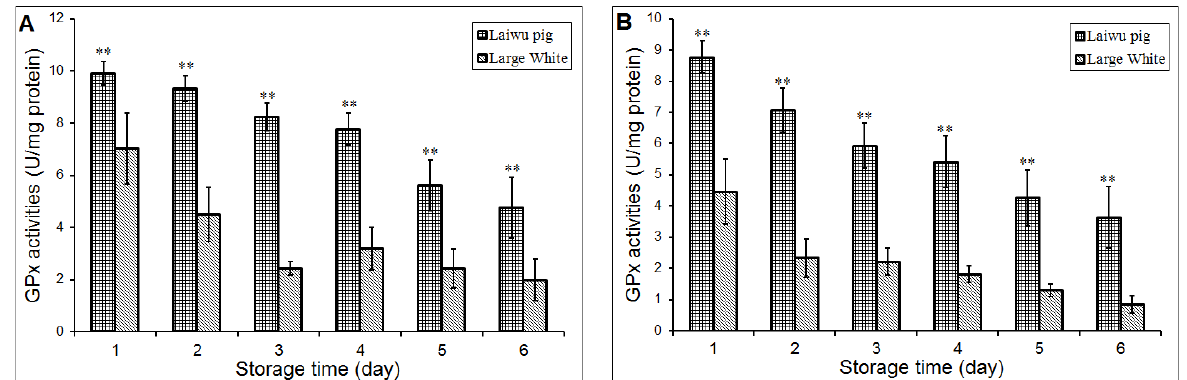
Figure 3. Comparison of muscle GPx activity. The muscle samples of Laiwu pig and Large White pig stored at 4  C (A) and 20  C (B) for 1-6 days. Each value is represented as the means  SEM ( n = 6). Asterisks indicate differences that are statistically significant (** p<0.01).